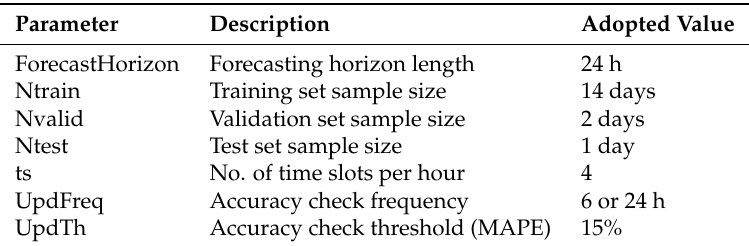
Table 2. Parameters Settings.